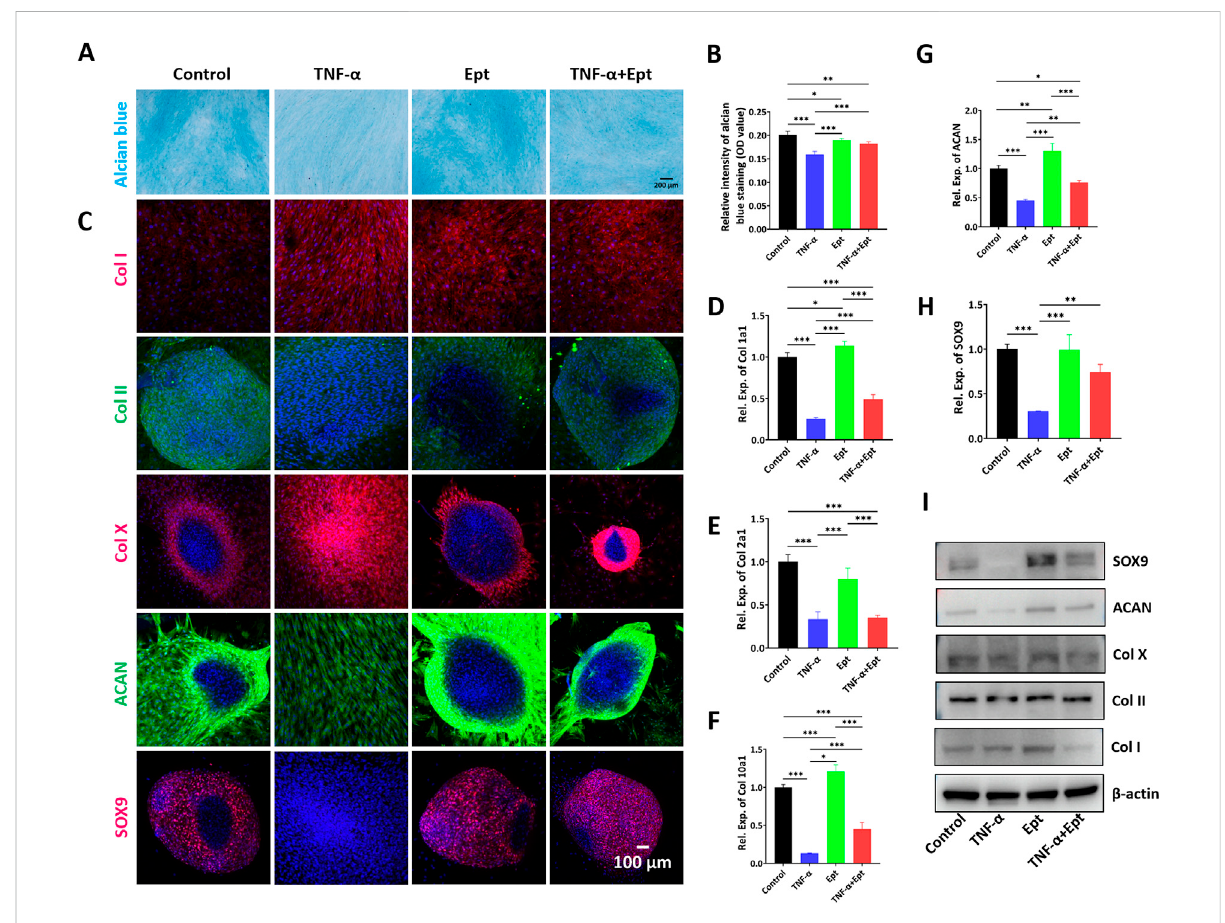
FIGURE 5 Effects of Ept on hBMSCs chondrogenesis. (A,B) Representative alcian blue staining and quantitative analysis ( n = 5), (C) Representative immuno fl uorescence images of Col I (red color), Col II (green color), Col X (red color), ACAN (green color) and SOX9 (red color), (D – H)